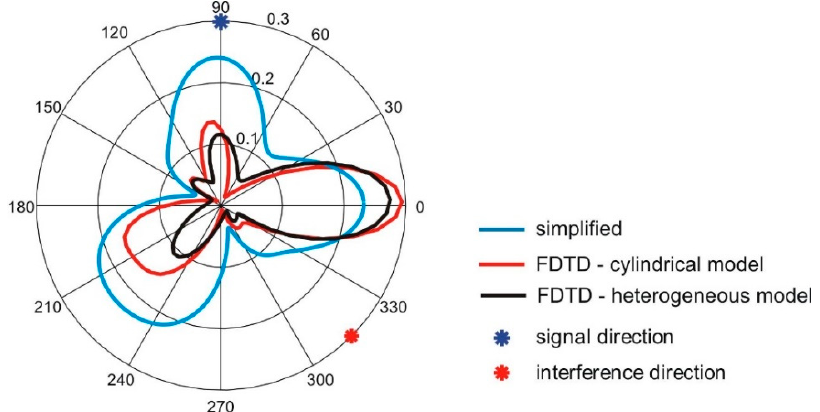
Figure 17. The radiation patterns of the antenna array for the worst combination of signal and interference angles: ( a ) before optimization, ( b ) after optimization.